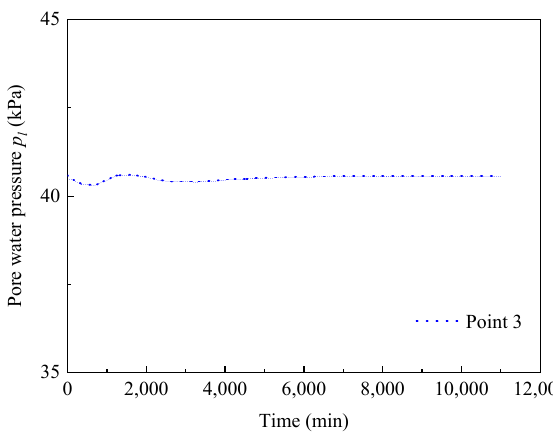
Figure 13. Evolution curve of pore water pressure in saturated zone of railway subgrade.